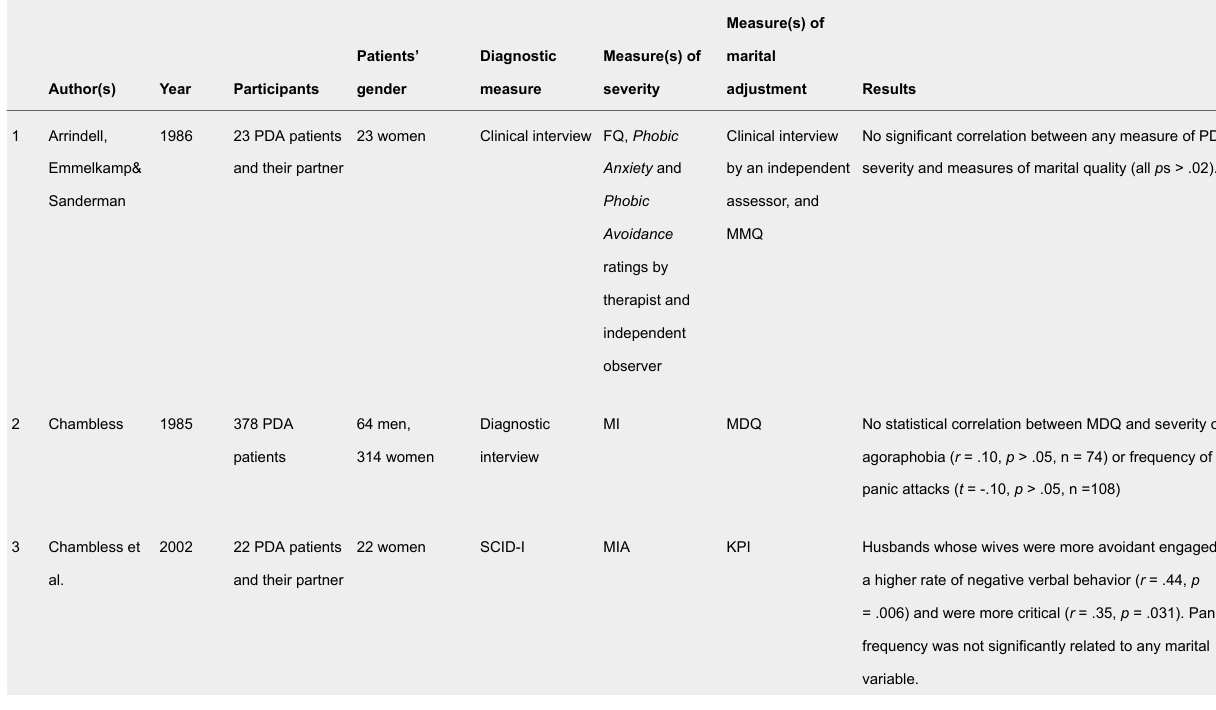
Description of Studies Examining the Association Between Marital Adjustment and